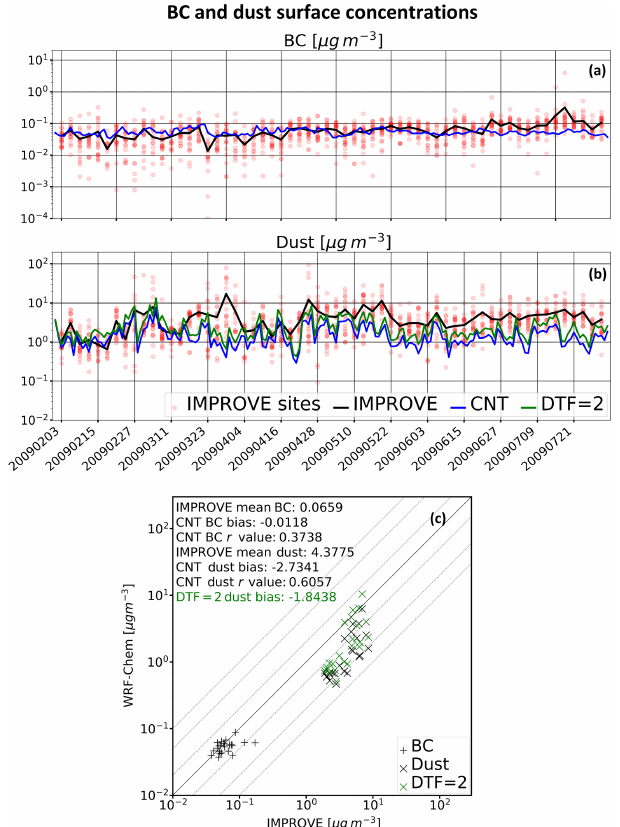
Figure 5. Time series of BC (a) and dust (b) from CNT and IM- PROVE. Red transparent circles denote individual IMPROVE mea- surements. The lower panel (c) shows the same data as in the top and middle panels, except the data are temporally averaged from February through July instead of spatially averaged.